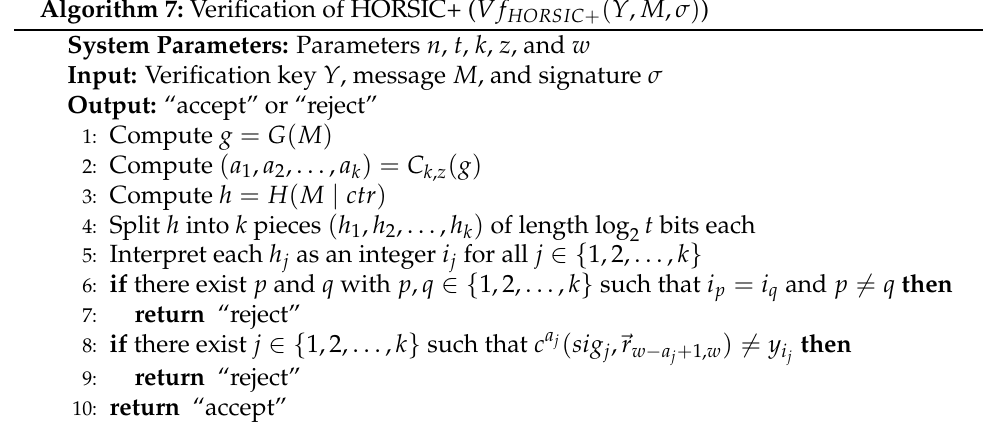
Algorithm 7: Verification of HORSIC+ ( V f HORSIC + ( Y , M , σ )